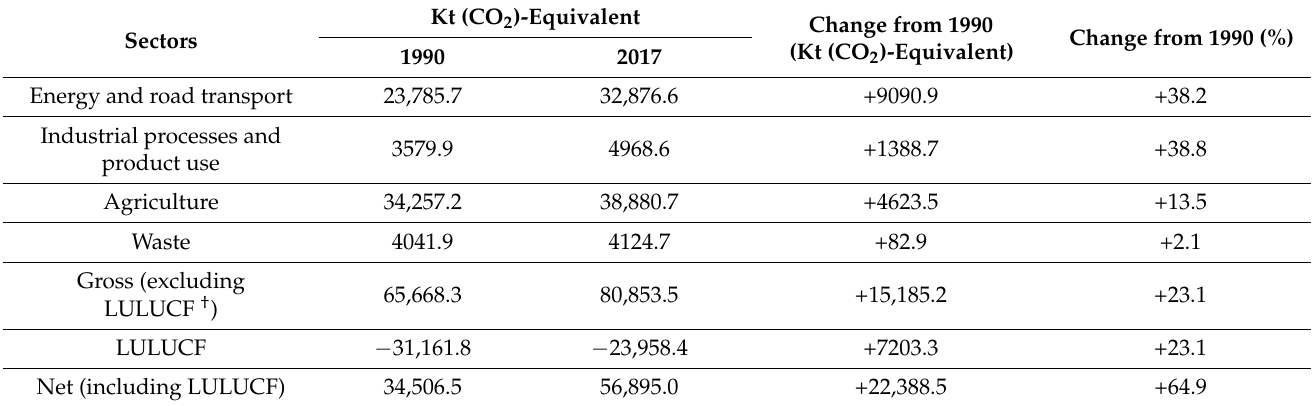
Table A1. New Zealand’s CO 2 emissions by sector between 1990 and 2017.